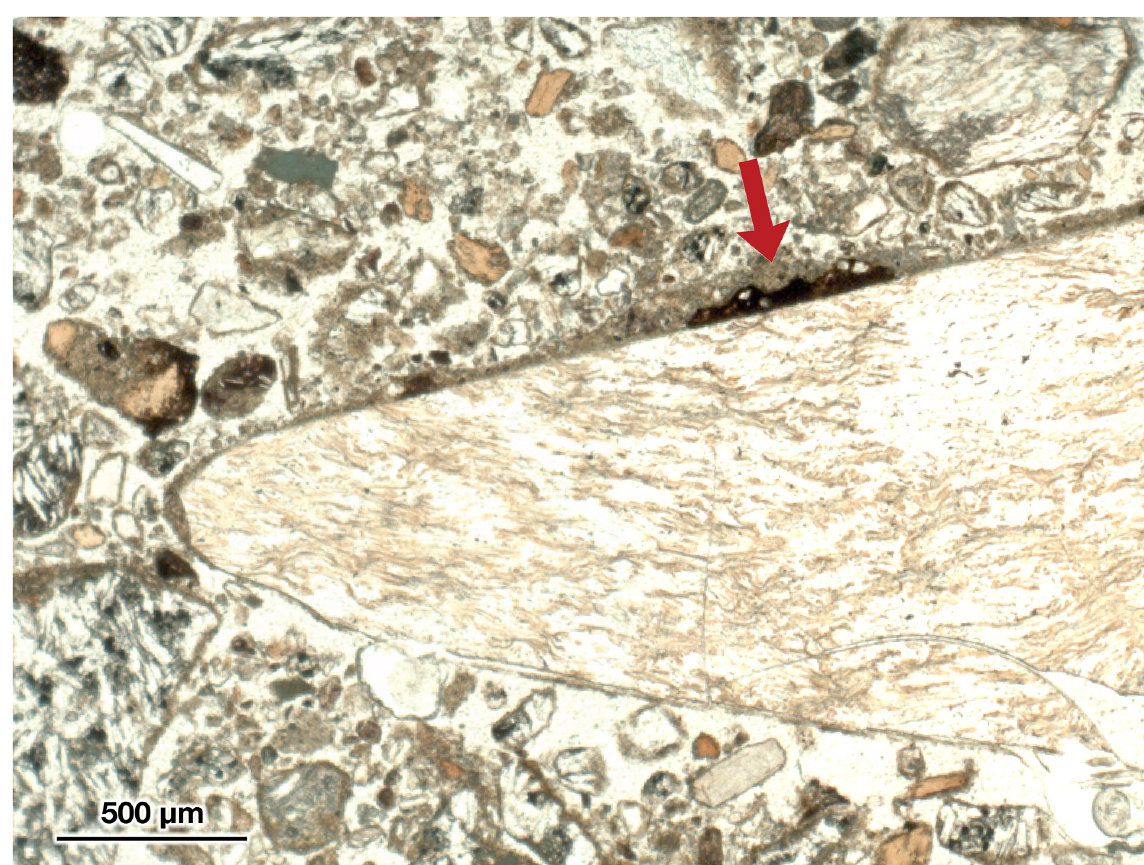
Fig 10. A thin section of LKT1 Unit 5 sediments. Viewed in plane polarized light, microphotograph of a sediment thin section from Unit 5 shows an obsidian flake (center) with an adhered residue (as indicated by the red arrow). Micrograph by one of the authors